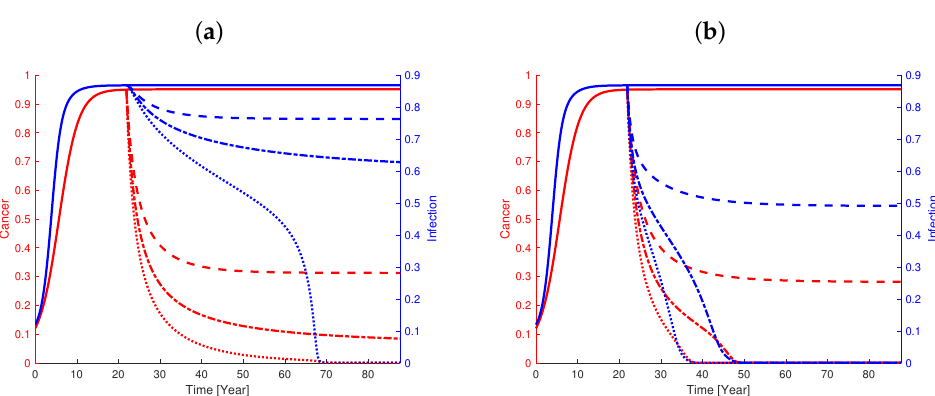
Figure 6. The progression of cancer (red curves and left axis) and infection (blue curves and right axis) for default parameter values upon escape (full curves). ( a ) At year 22, a virtual patient with full-blown cancer-infection is exposed to CAR T-cell therapy by adding modified cancer specific effector T-cells. By adding 60% and 80% CAR T-cell of the otherwise normal response (stipulated curves and dash-dotted curves, respectively), cancer and infection are reduced but not normalized. Increasing the dosage to 100% causes the virtual patient to be cured but after an insufficiently long period of time (50 years). Cancer burden decays ’exponentially’ while infection shows a pronounced shoulder in the response before continuing the fast decay. Ultimately the state approaches the dormant state. If treatment is stopped before the infection level becomes sufficient low, the virtual patient experiences a relapse (not shown). If treatment is stopped after both cancer and infection have been lowered to the neighborhood of the dormant state, no relapse is observed. ( b ) Similar to left panel but, in addition to CAR T-cell therapy, there is also an anti-inflammatory treatment provided with similar dosages. These combi-treatments result in significantly improved effects of the in silico treatments compared to the corresponding CAR T-cell mono-therapy. For the 80% dosage, the combination treatment becomes successful. For the largest dosage of 100%, the treatment time to reach success is reduced from 50 years to 12 years and the time to cure is halved compared to the combination treatment with 90%